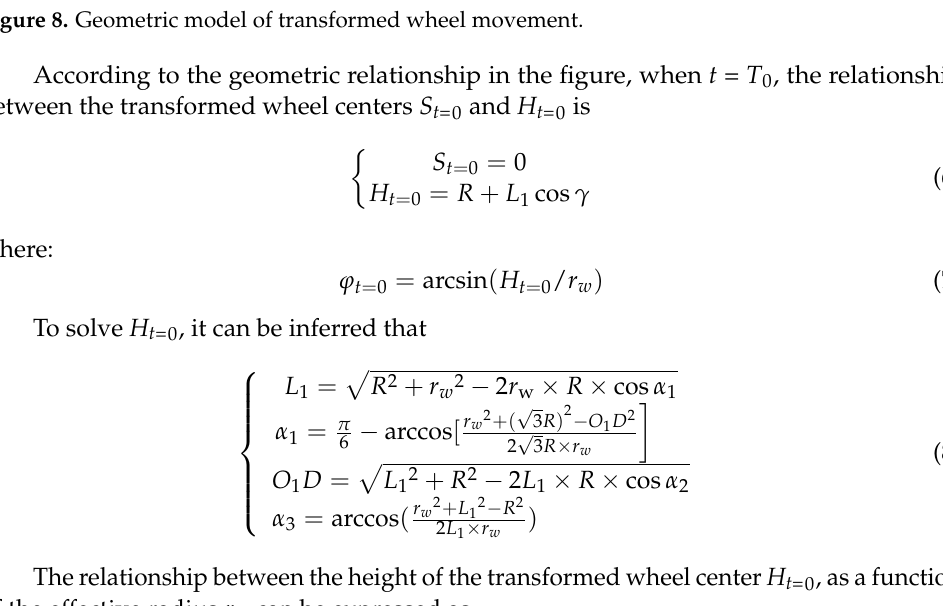
Figure 8. Geometric model of transformed wheel movement.